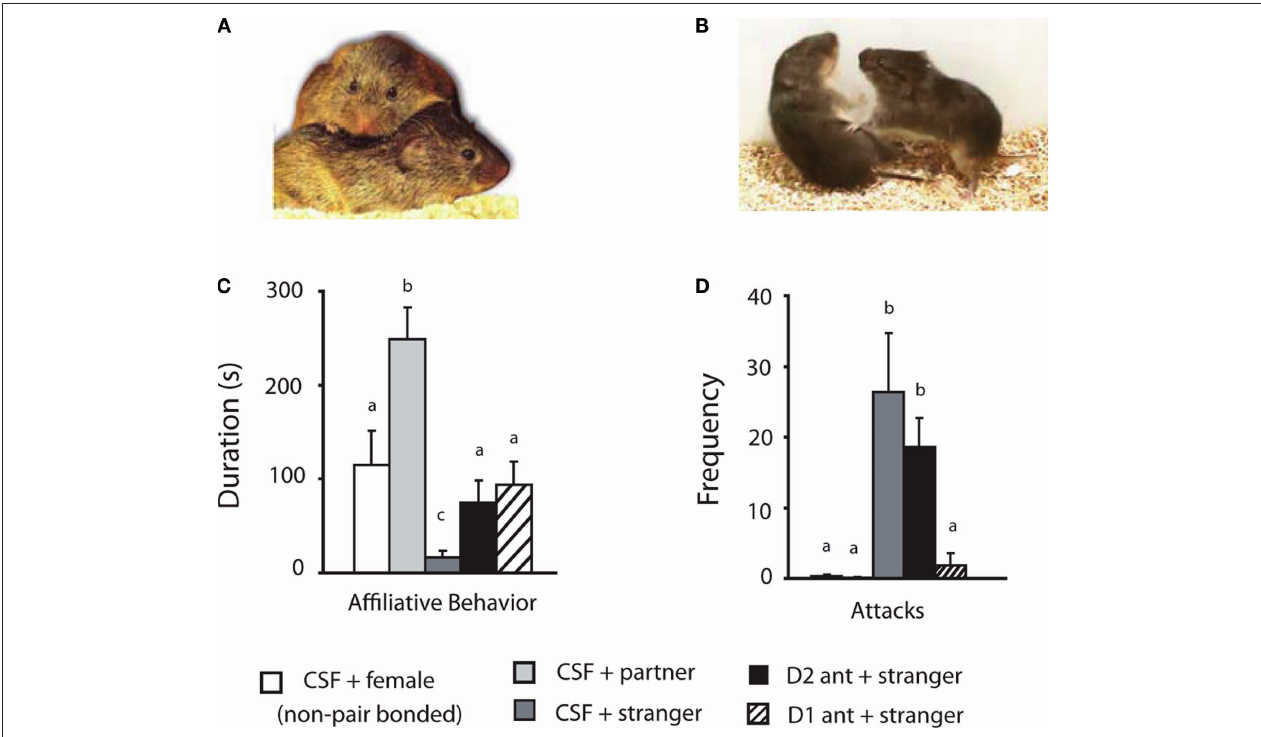
FIGURE 5 | Dopamine regulation of pair bond maintenance as indicated by selective aggression toward novel females. (A) Photo of pair bonded mates engaged in affi liative behavior (typically huddling or side-by-side contact). (B) Pair bonded male (right) showing aggressive behavior toward an unfamiliar/novel female (stranger; left). (C) Quantifi cation of affi liative behavior during a 6-min resident intruder test of selective aggression. Pair bonded males show signifi cantly more affi liative behavior than other group when presented with their familiar partner, but signifi cantly less affi liation when